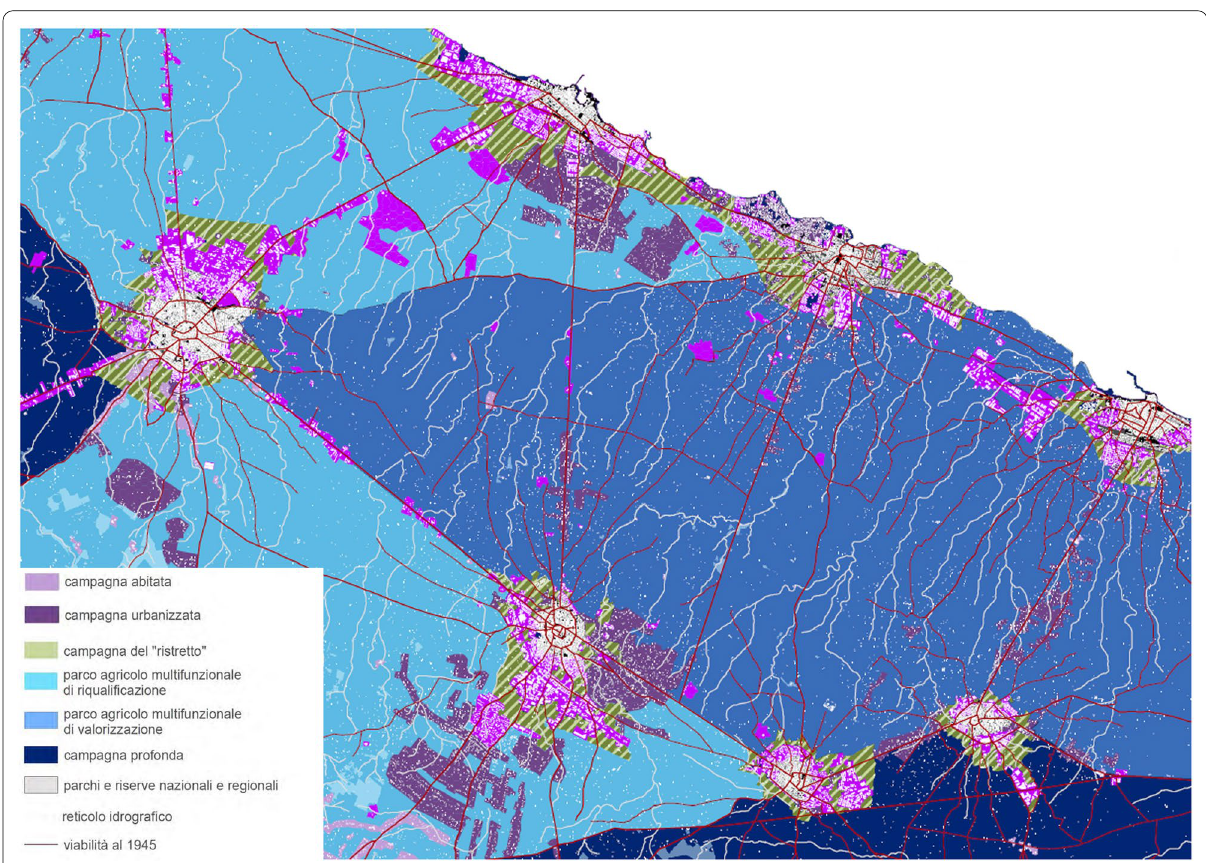
Fig. 2 Details of the components of the City-Country Pact strategy. The image highlights the relationship between the settlements and the ristretto areas (yellow striped pattern), intended as ‘belts’ of valorisation and interaction with the countryside. It also highlights the relationship between rural sprawl (purple shapes) and the extensive network of historic roads connecting urban centres. Source: PPTR, ‘Guidelines for the City-Country Pact: redevelopment of the periphery and peri-urban agricultural areas’, elaborate 4.4.3, p. 27